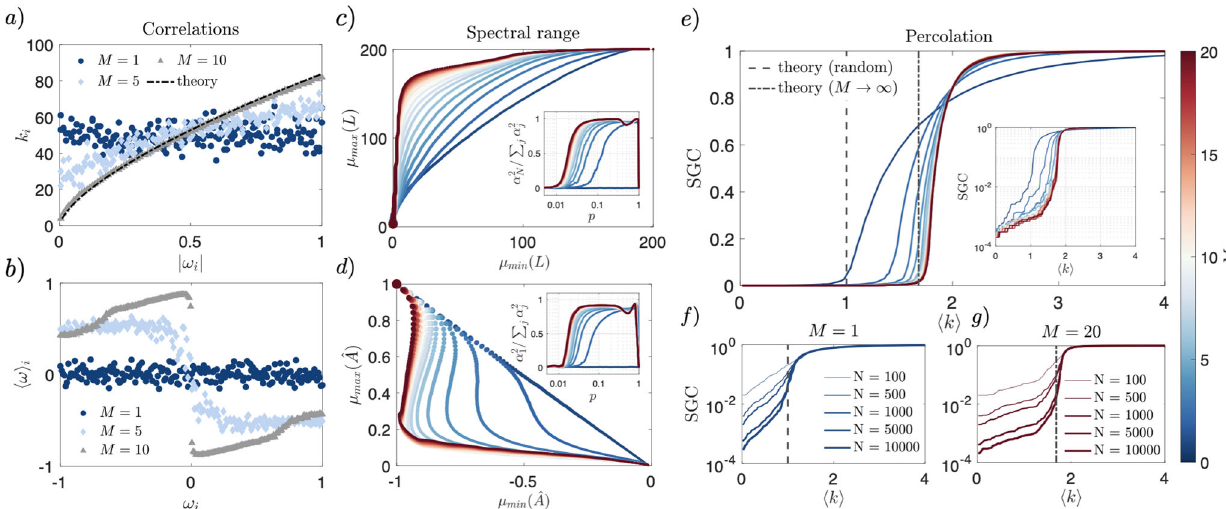
Fig. 2 Explosive fi ngerprints. Left column: a scatter plot of the tuples ( ∣ ω i ∣ , k i ) and b ( ω i , 〈 ω 〉 i ) — where 〈 ω 〉 i is the average frequency of the neighbors of the i th-node — for each oscillator at p = 0.1, in a single realization of the forward process, for three values of sampling and N = 200, including in a the deterministic prediction of Eq. (4). Middle column: scatter plot of c the maximum and minimum eigenvalues of the Laplacian matrix, μ min ( L ) and μ max ( L ) and d of the normalized Adjacency matrix, μ ð ^ A Þ and μ ð ^ A Þ at different p -steps of the forward process (the size of the dots decreases for larger p ) for min max different values of M . In the inset, we plot the relative correlation α i = 〈 ω , v i 〉 between the frequency vector and the eigenvector of L (or ^ A ) associated with the maximum (or minimum) eigenvalue. Right column: e Evolution of the average size of giant component (SGC), for sampling ranging from the random scenario of ( M = 1) to a more deterministic one with ( M = 20) in a network of size N = 5000. Results are averaged over 20 realizations of the process. Inset in e shows a single realization in log scale. In f we show the effect of network size on the percolation transition for the M = 1 and g M = 20 scenarios. It is observed that larger and more deterministic networks under the rule of Eq. (3) experiment sharper